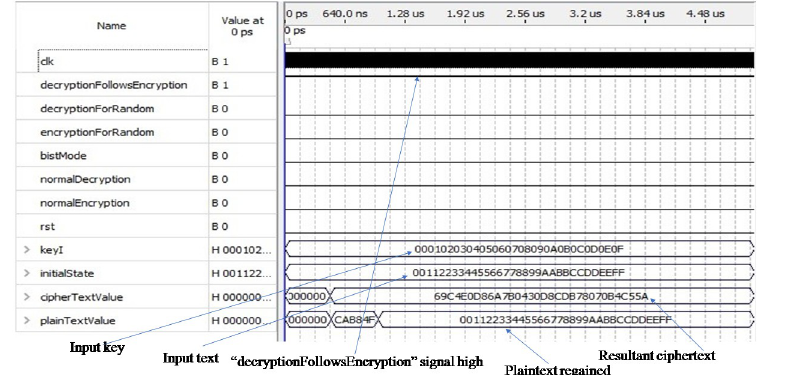
Fig 7. Simulation result of decryption process following encryption process.